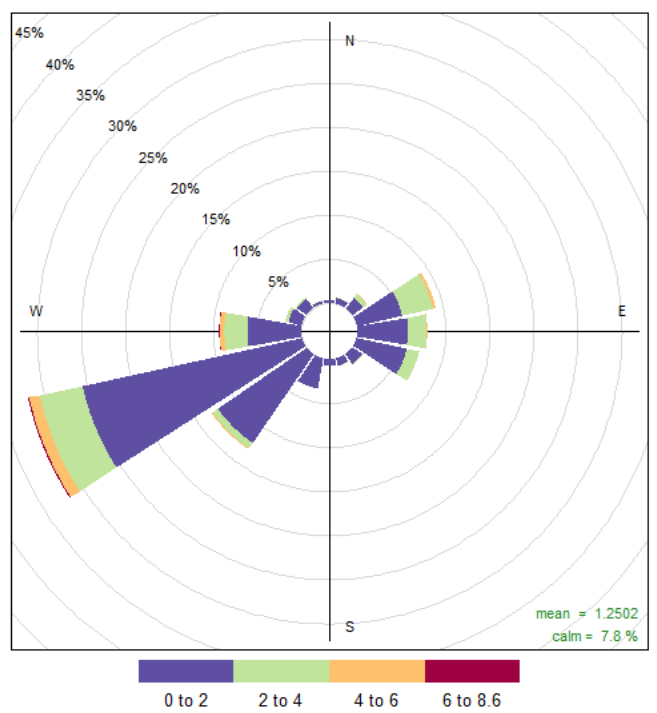
Figure 6. Wind rose of the wind measured in the building.